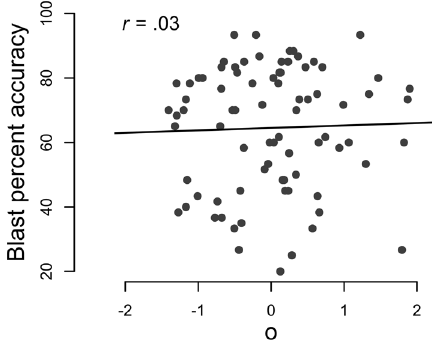
Fig. 2 Correlation between o and percent accuracy on the Blast